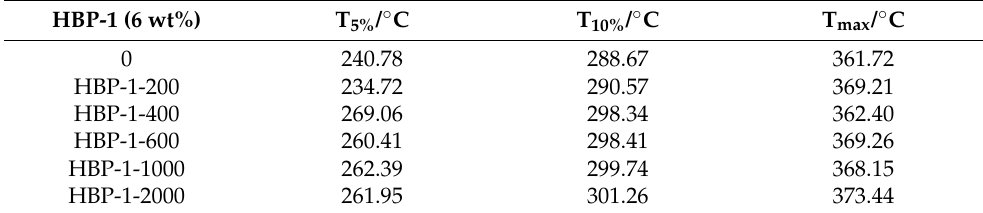
Figure 3. TG ( a , c ) and DTG ( b , d ) curves of the neat UPR and the UPR composites. Table 1. T 5% ,T 10% and T max of the neat UPR and the UPR composites. HBP-1 (6